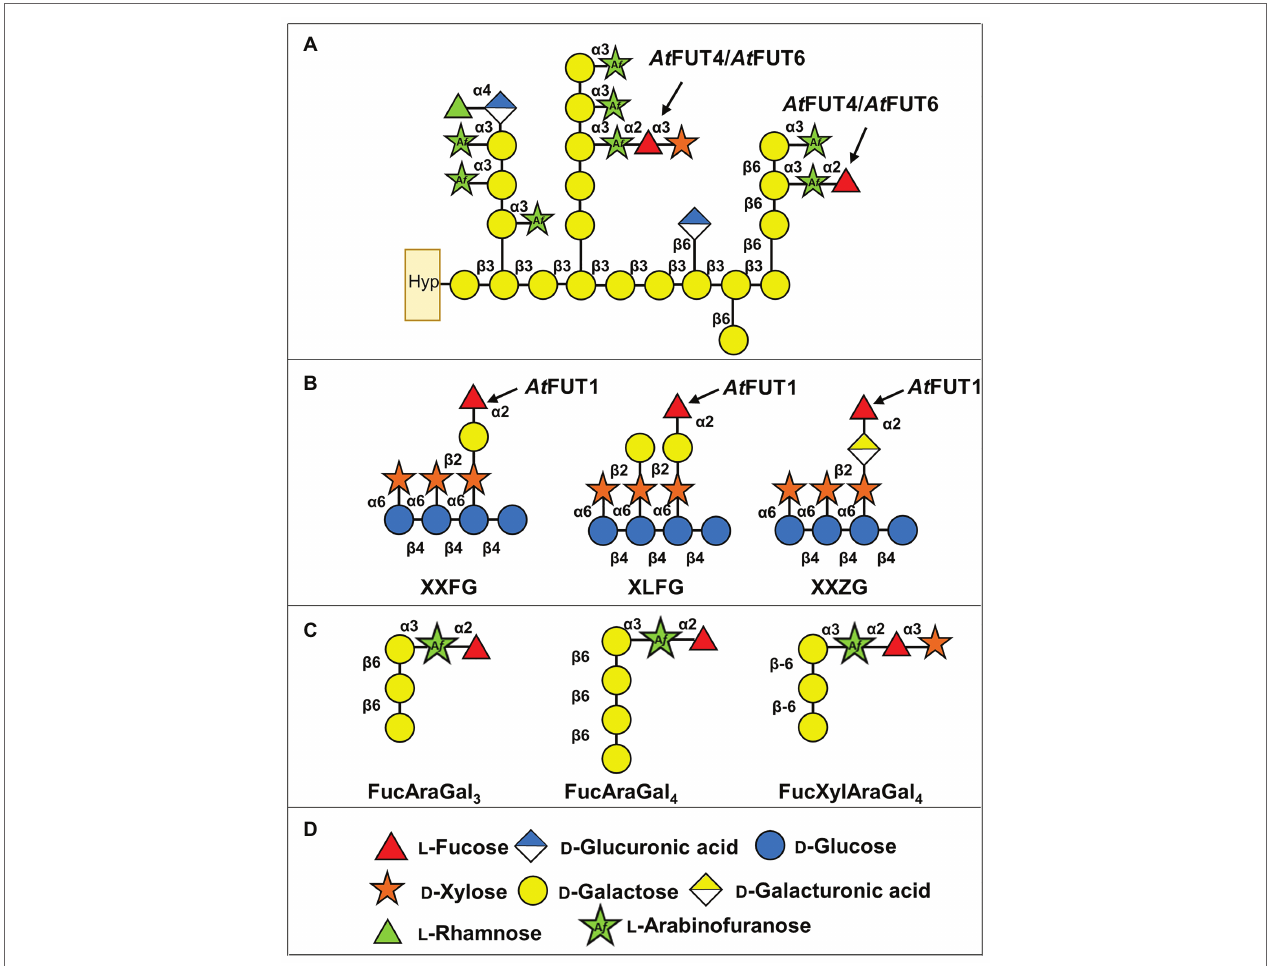
FIGURE 1 | Scheme showing the structures of xyloglucan (XyG) and arabinogalactan (AG) proteins (AGPs) from Arabidopsis thaliana with the predicted activities of At FUT1 and At FUT4/ At FUT6. (A) Representation of A. thaliana AGPs, and the putative activities of At FUT4 and At FUT6. Hyp, hydroxyproline. (B) Fucosylated XyG oligosaccharides derived from A. thaliana XyG (Peña et al., 2012; Tuomivaara et al., 2015). (C) Fucosylated AGP side chains derived from A. thaliana AGPs (Tryfona et al., 2012, 2014). (D) Symbol